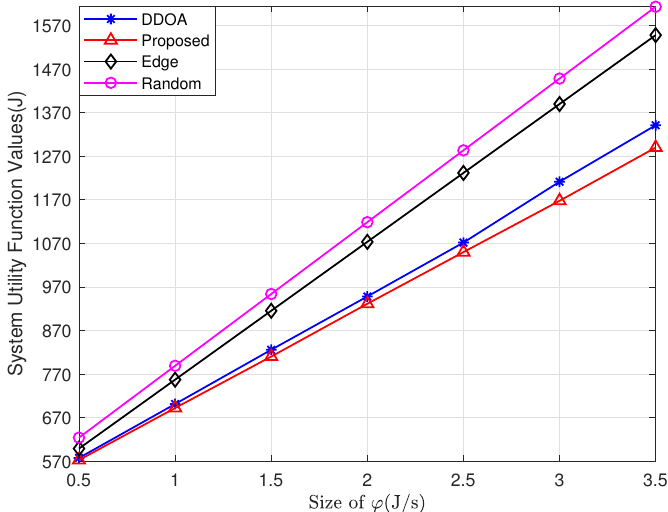
Figure 4. The system utility function values under different parameters ϕ for different offloading